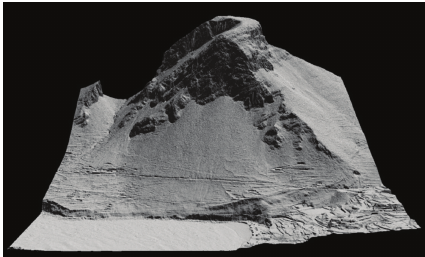
Figure 2: High-resolution DTM obtained by airborne full-wave- form laser